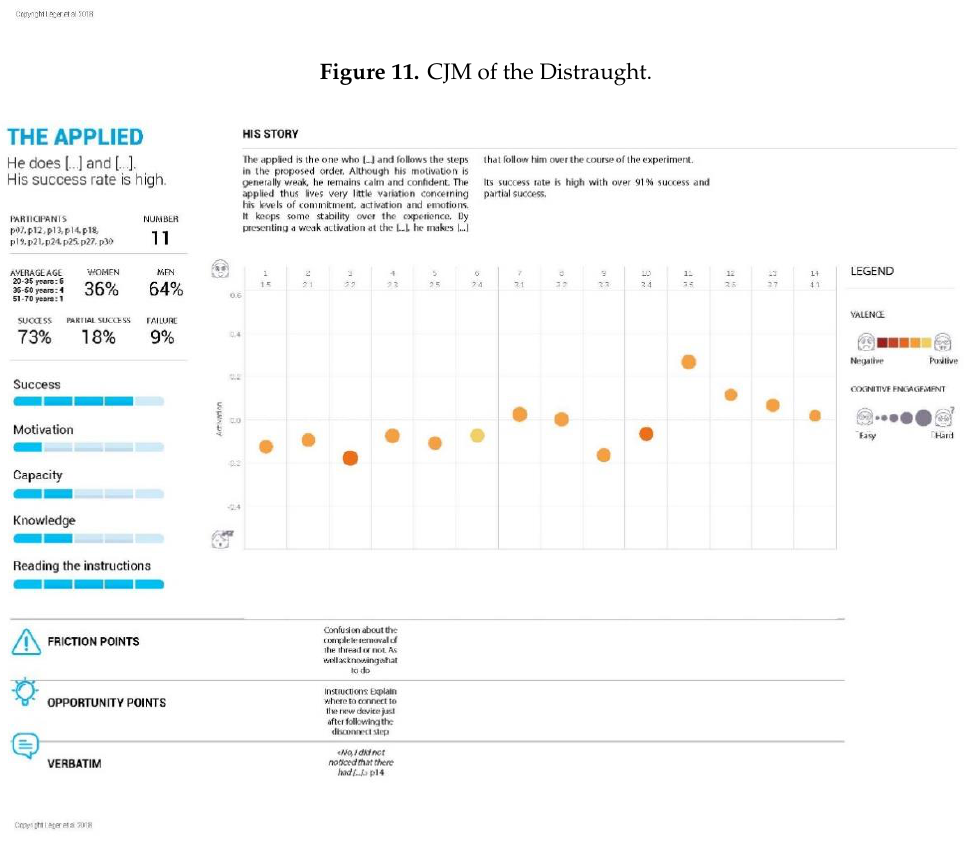
Figure 12. CJM of the Applied.